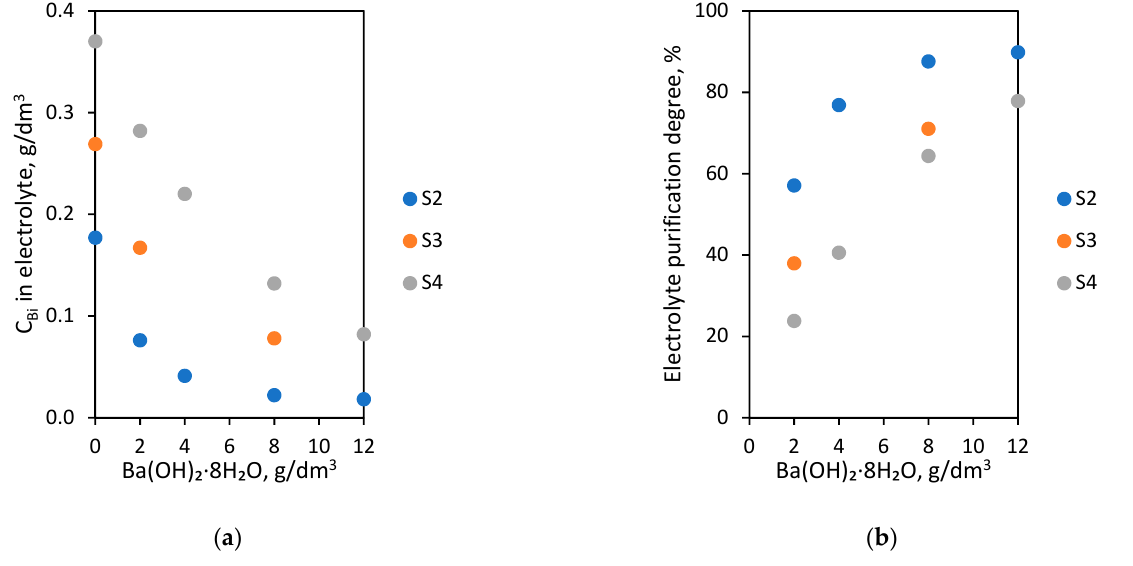
Figure 6. Dependence of initial Bi concentration (0.177, 0.269, 0.370 g/dm 3 ) and amount of barium hydroxide octahydrate added on ( a ) Bi concentration in electrolyte; ( b ) electrolyte purification degree.